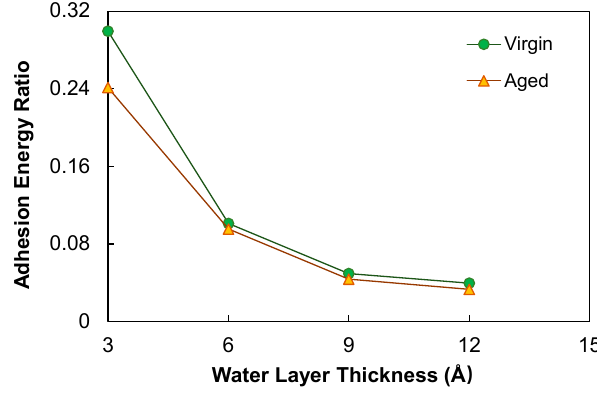
Figure 12. Adhesion energy ratio for the wet condition.